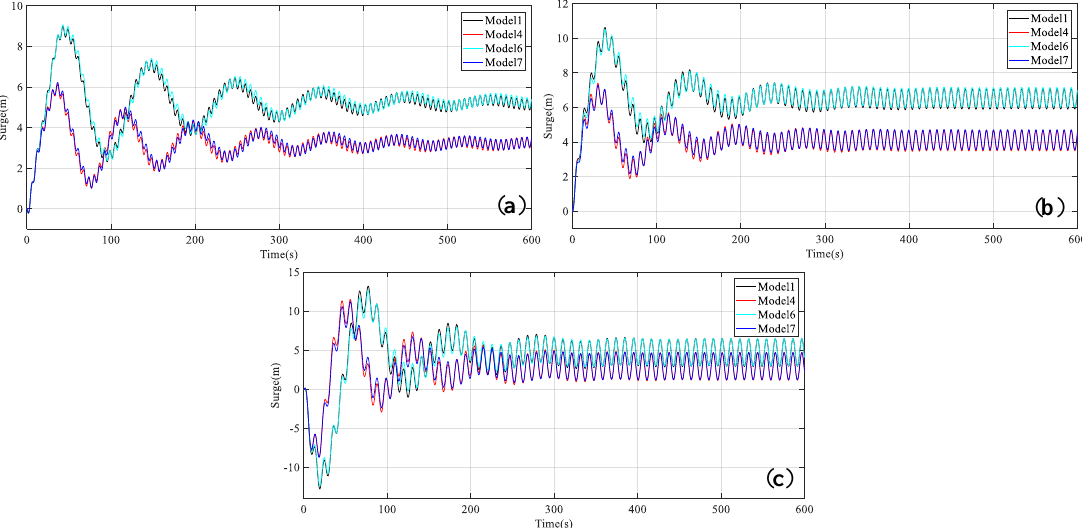
Figure 20. Comparison of the surge motion of Model 1, 4, 6, and 7 in the time domain: ( a ) LC1; ( b ) LC2; and ( c ) LC3.